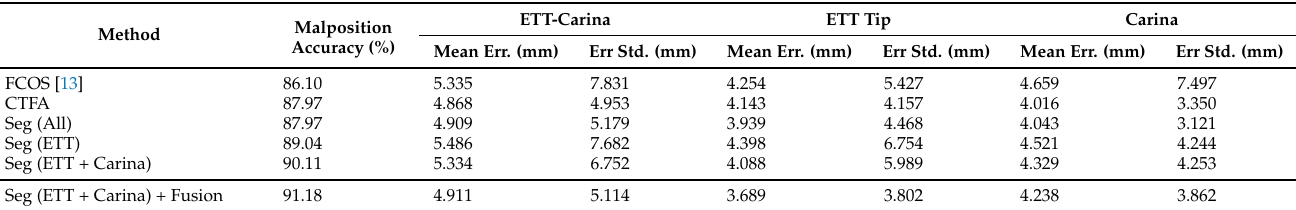
Table 21. The results of employing mask branch into